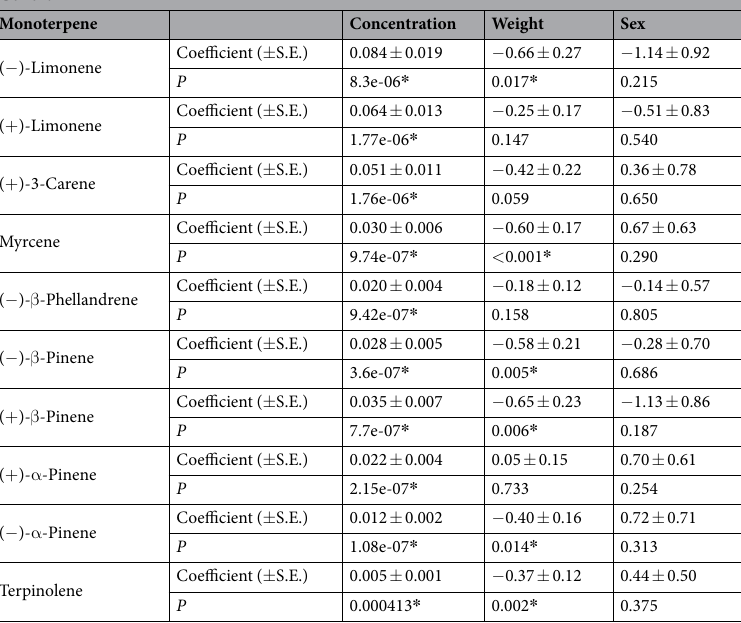
Table 4. The independent effects of concentration, body weight and sex on mortality for each monoterpene tested with MPB from cohort 2. Logistic regression analysis was used to assess the effects of monoterpene concentration, body weight, and sex on mortality for each of the monoterpenes tested. The coefficient indicates the magnitude and direction of each of these effects on mortality. Concentration: A positive coefficient indicates a positive relationship between increasing concentration and mortality. A significant positive coefficient was found for all monoterpenes tested indicating increasing toxicity at increasing concentrations. Weight: A positive coefficient indicates a positive relationship between increasing weight and mortality. Most monoterpenes had a significant negative coefficient, indicating heavier beetles survived more often. Sex: A positive coefficient indicates females survived more often than males. A negative coefficient indicates males survived more often than females. All monoterpenes did not show a significant coefficient indicating that sex did not influence survival. * Denotes P -value <